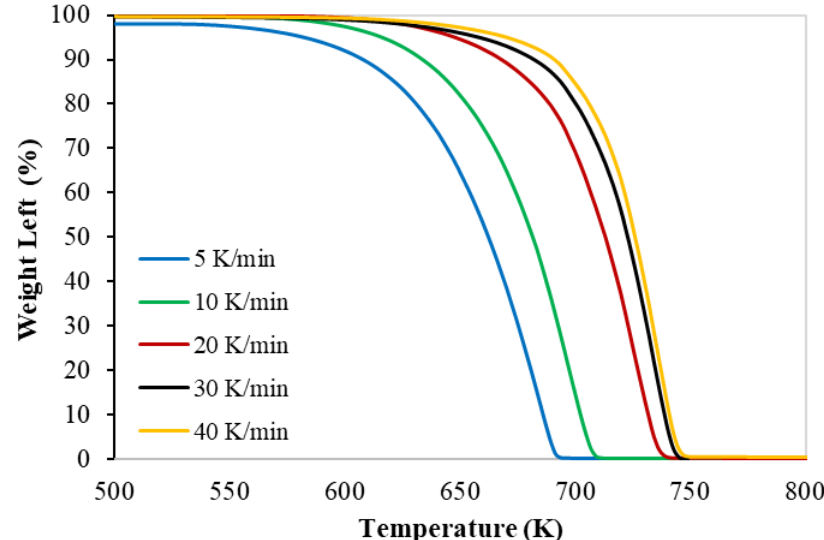
Figure 1. Thermogravimetric (TG) curves of the PP pyrolysis with different heating rates.